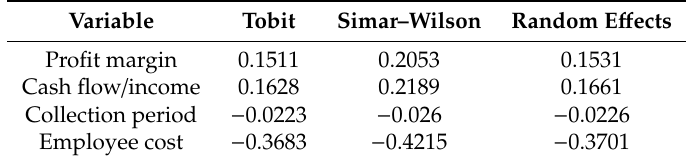
Table 7. Comparison of marginal e ff ects, Tobit, Simar–Wilson and random e ff ects